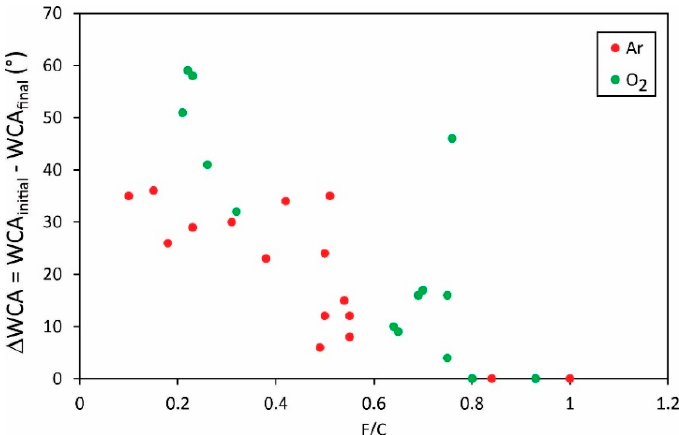
Figure 8. The change of the static water contact angle versus the O/C ratio in the surface film as probed by XPS.